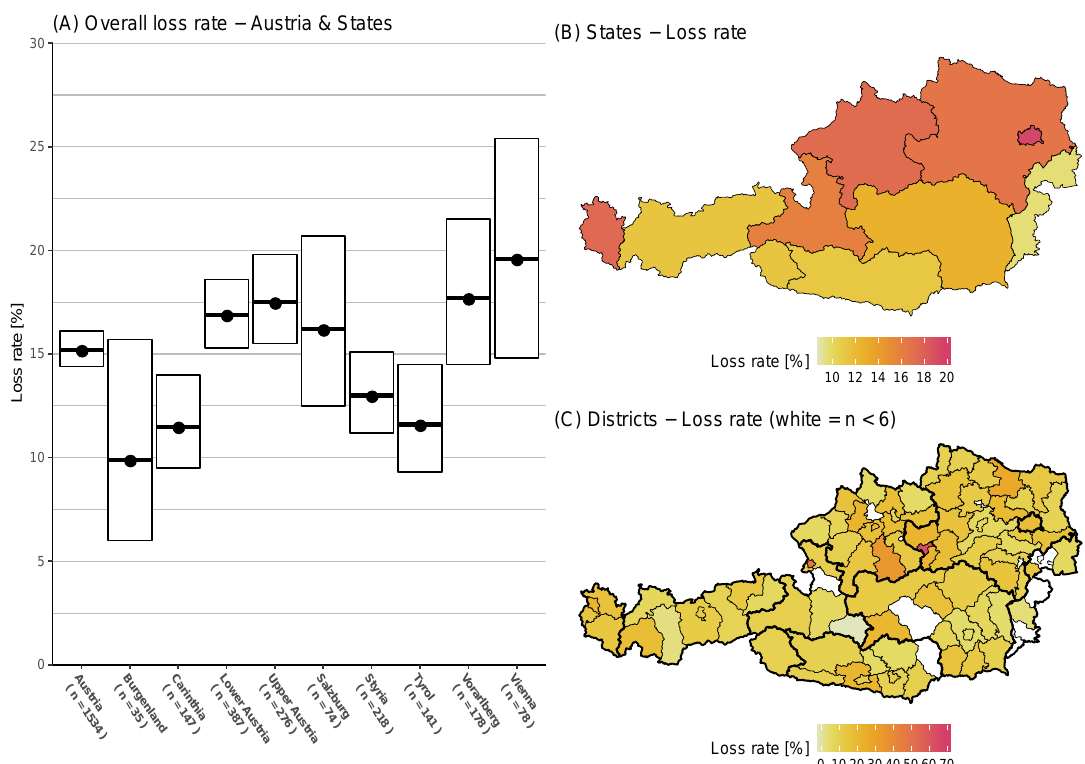
Figure 2. ( A ) Austria and its state winter honey bee colony loss rates (and 95% CI) over the winter period of 2018/2019. ( B ) Map with loss rates colour coded on the Austrian state level. ( C ) Map with loss rates colour coded on the district level: white spots are n < 6.